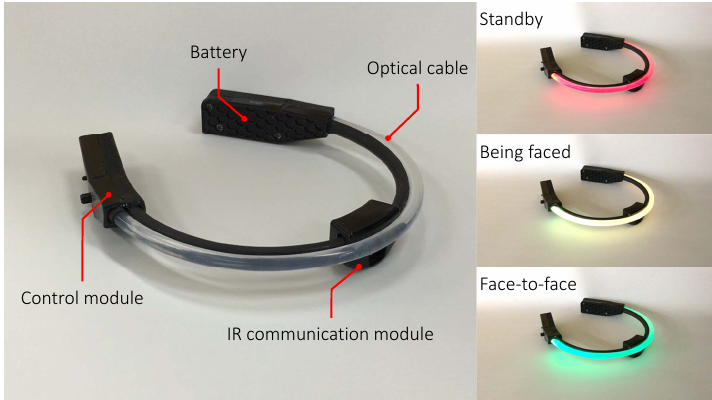
Figure 5. Prototype of the FaceLooks device: control module, IR communication module, optical cable, and battery fixed to a headband.